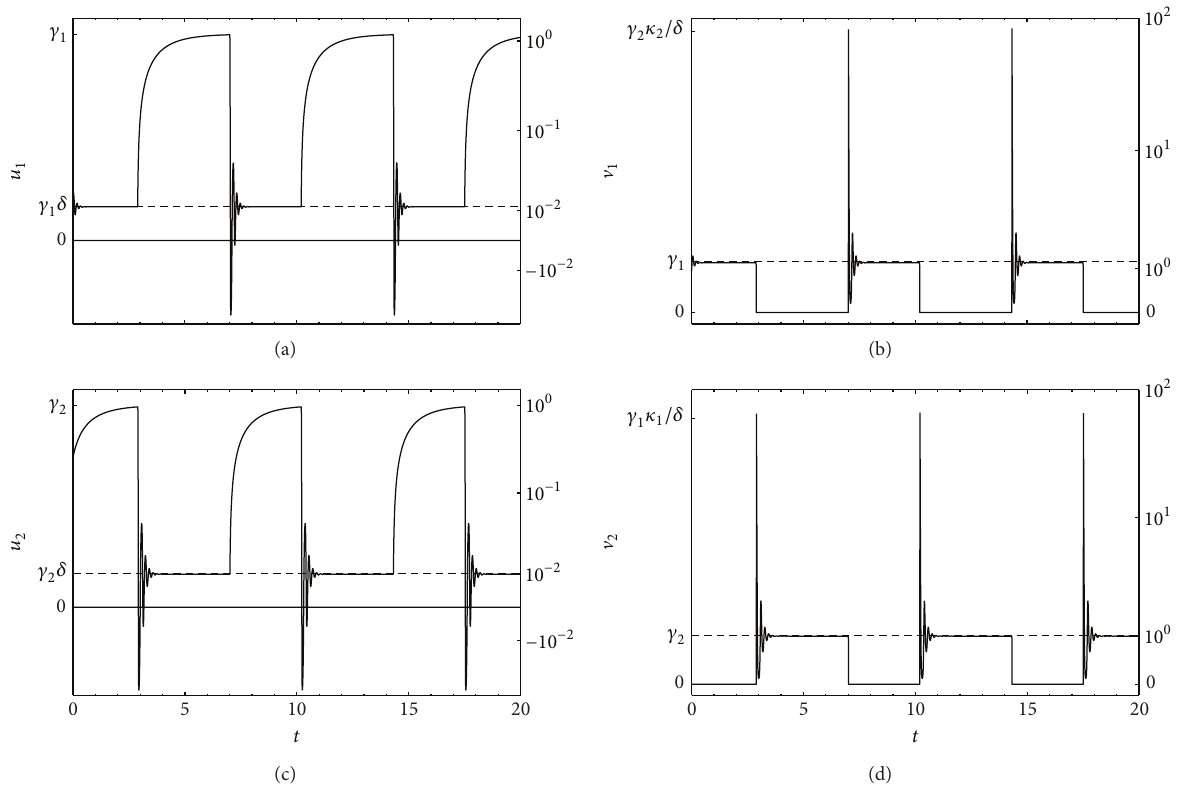
Figure 7: Time profiles of antiphase relaxation oscillations in two coupled CR pairs modeled by (1a)–(1d). (a) and (b) show the, respective, resource 1 and consumer 1; (c) and (d) display the, respective, resource 2 and consumer 2. Numerical values of the parameters are those mentioned in the caption of Figure